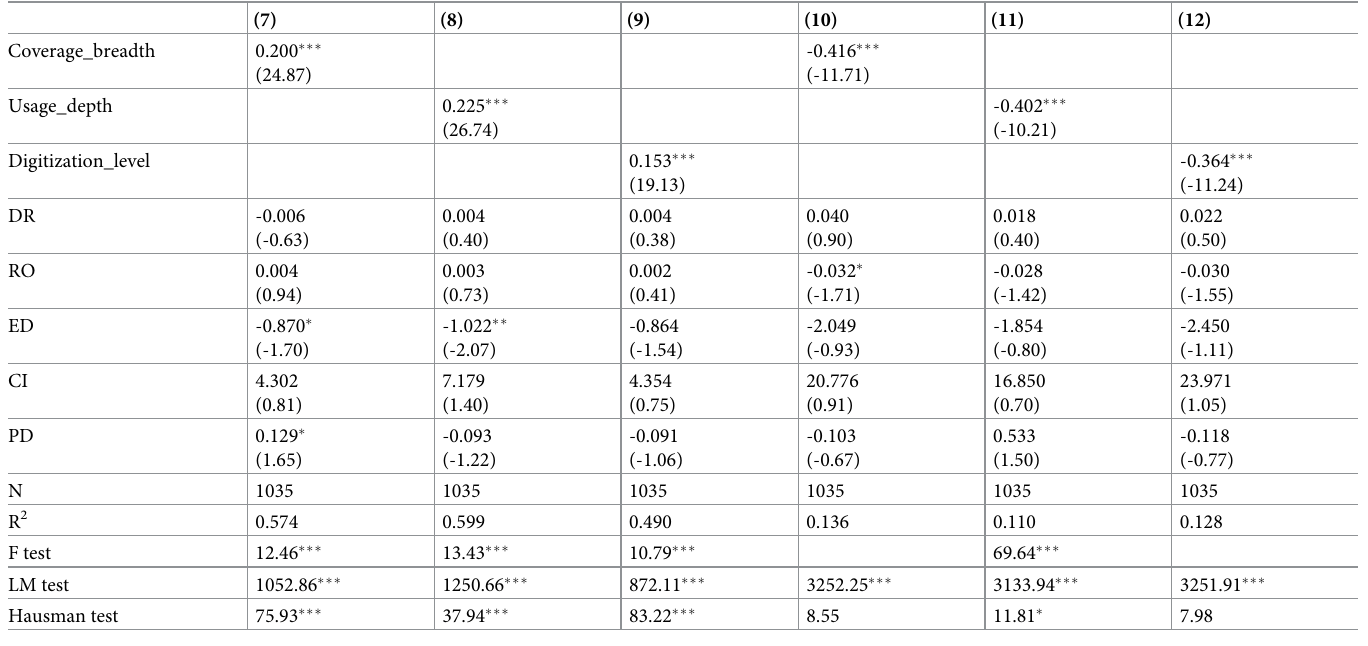
Table 4. Regression results of decomposition